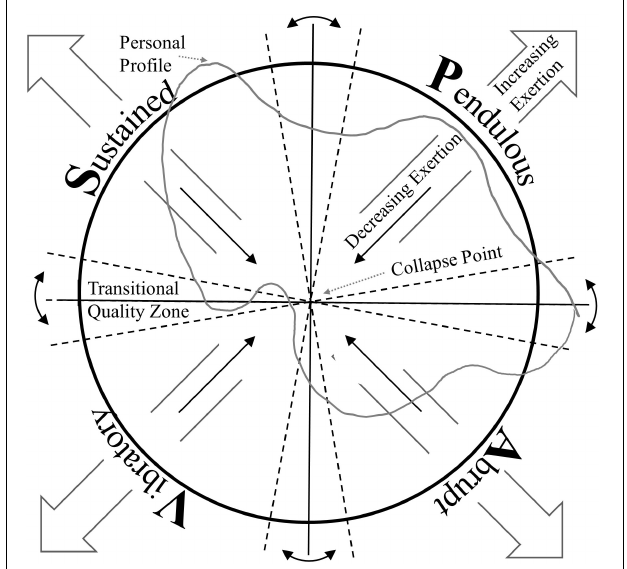
FIGURE 1 | The Autosphere: a graphic depiction of the primary qualities (pendulous, sustained, abrupt, and vibratory) and their transitional zones (e.g., sustained-pendulous). Perceived exertion is indicated by distance from the center or collapse point. Personal profile is an example of a hypothetical student’s reflection on their own movement